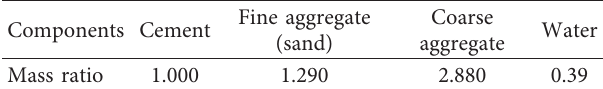
Table 2: C40 mix proportion. Table 3: C50 mix